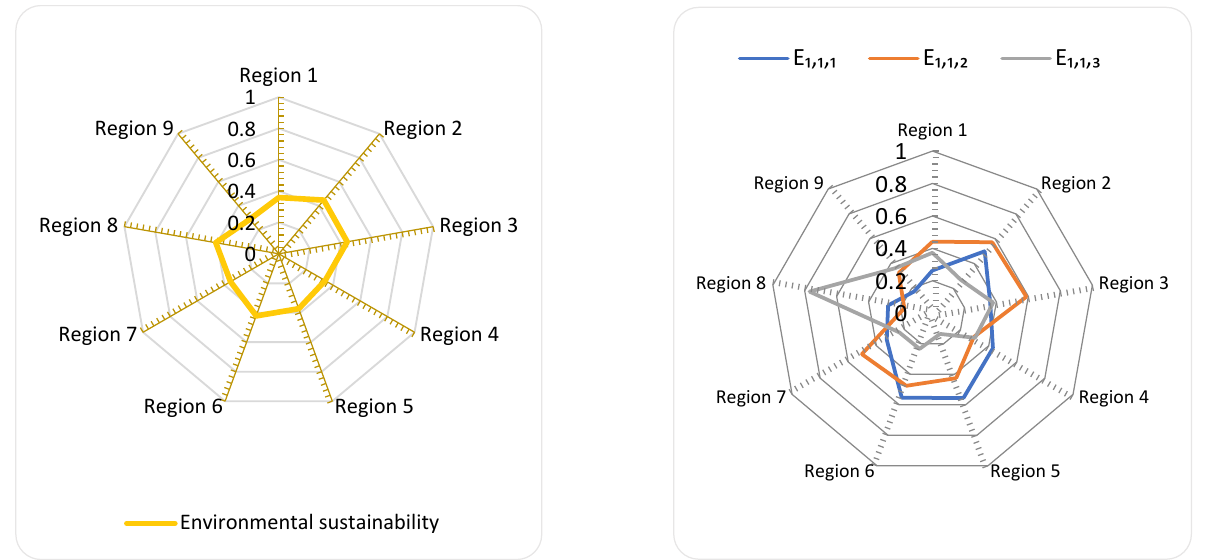
Figure 8. Assessment of environmental sustainability in the 9 regions: land use capability (E 1,1,1 ), health and environmental quality (E 1,1,2 ), and energy consumption and transportation (E 1,1,3 ).